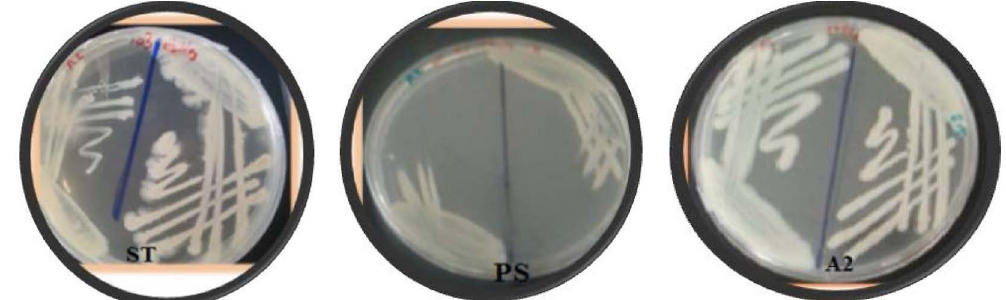
Fig. 4. Growth of ST, A2 and PS on agar plate contain different concentrations of Pb(NO